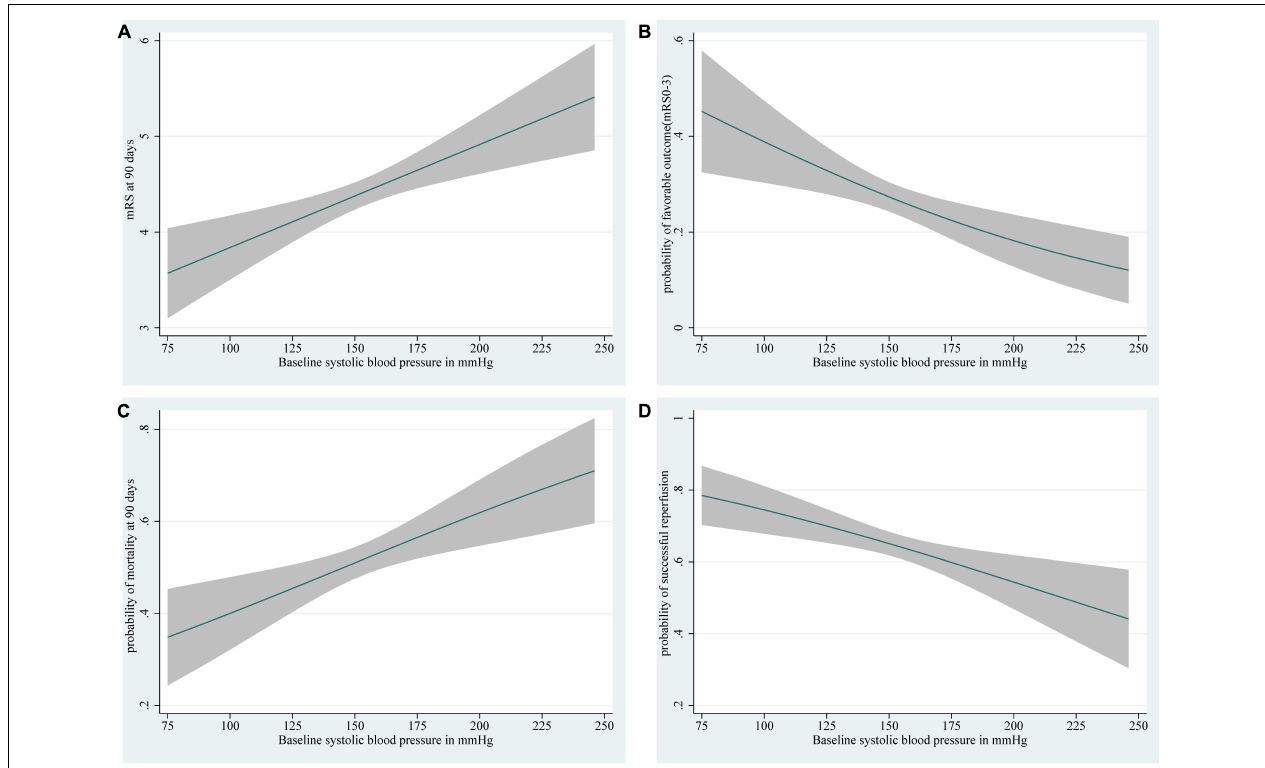
FIGURE 2 | Depiction of (A) the mRS score at 90 days, (B) the probability of a favorable outcome (mRS score 0–3), (C) the probability of 90-day mortality, and (D) the probability of successful reperfusion with 95% confidence intervals for each level of baseline SBP. The ranges of the x -axes correspond to the minimum and maximum values of SBP in the study (SBP: 75–246 mm Hg). Curves show (A) the increases in mRS score at 90 days, (C) an increased probability of 90-day mortality, (B) a decrease in predicted favorable outcome probabilities, and (D) a decrease in the probability of successful reperfusion with an increase in SBP. SBP, systolic blood